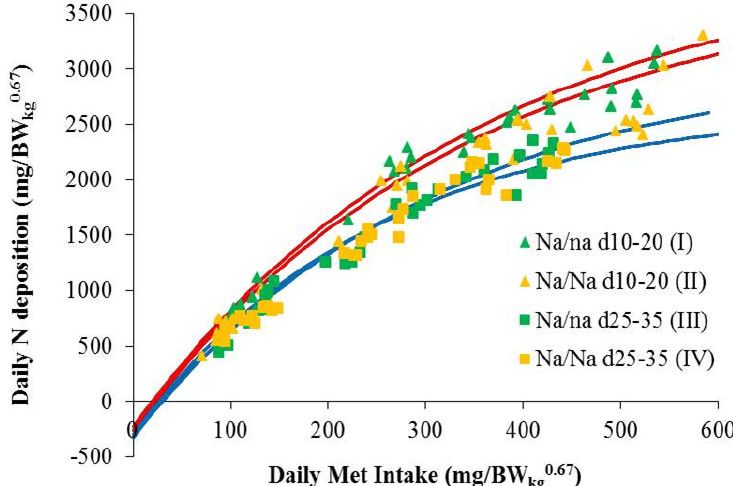
Figure 1. Daily N deposition (ND), depending on Met intake (MetI) and age period of male naked neck chickens. NR max T = theoretical maximum for daily N retention (mg/BW kg0.67 ); e = basic number of natural logarithm; bc − 1 = efficiency of Met utilization; NMR = daily N maintenance requirement (mg/BW kg0.67 ).